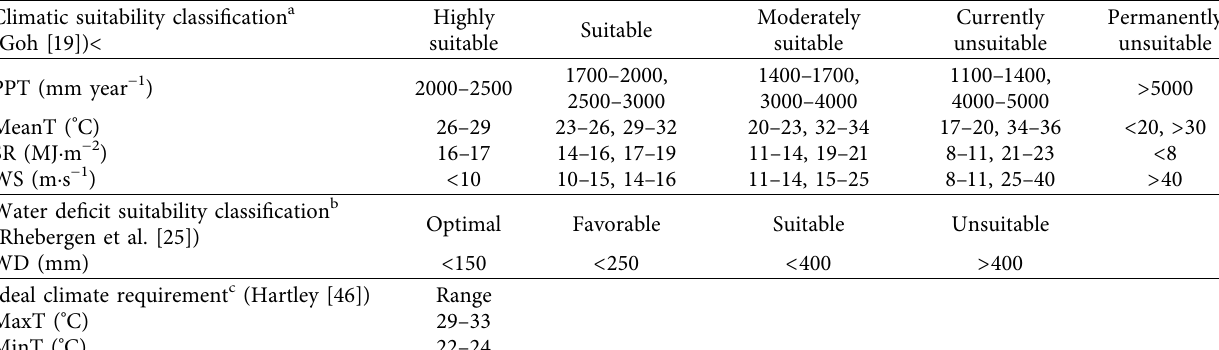
Table 3: Climatic suitability evaluation for oil palm.